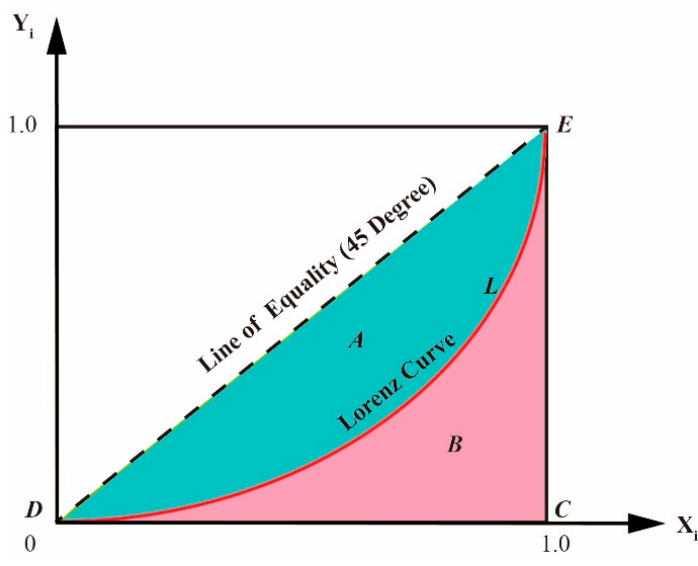
Figure 5. The Lorenz curve.